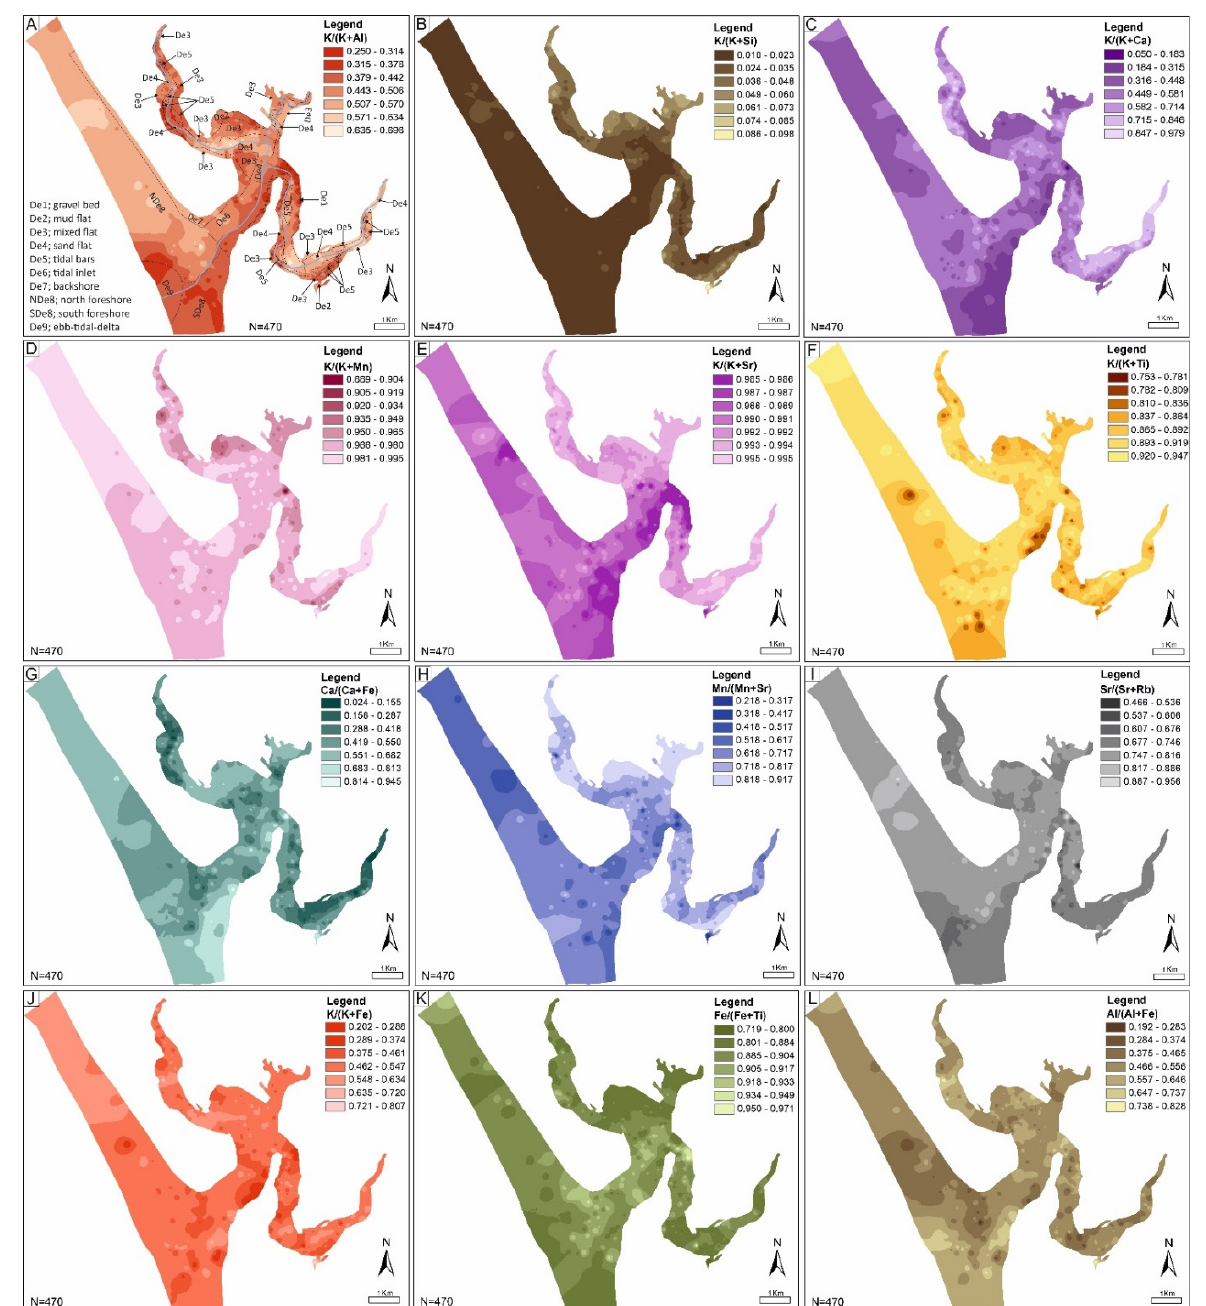
Figure 6. Spatial distribution of element indices ( A ) K/(K + Al), ( B ) K/(K + Si), ( C ) K/(K + Ca), ( D ) K/(K + Mn), ( E ) K/(K + Sr), ( F ) K/(K + Ti), ( G ) Ca/(Ca + Fe), ( H ) Mn/(Mn + Sr), ( I ) Sr/(Sr + Rb), ( J ) K/(K + Fe), ( K ) Fe/(Fe + Ti), and ( L ) Al/(Al + Fe) within the Ravenglass Estuary. Note that these element indices vary systematically for the Ravenglass Estuary sub-depositional